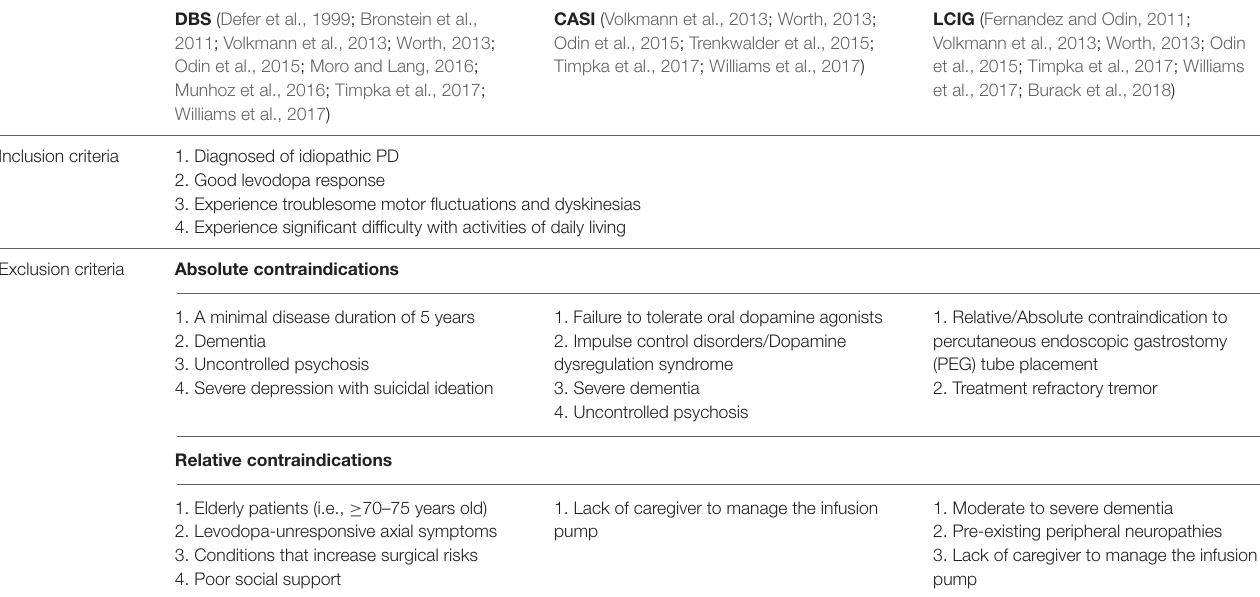
TABLE 1 | Inclusion and exclusion criteria for device-aided therapies of advanced PD. DBS (Defer et al., 1999; Bronstein et al., 2011; Volkmann et al., 2013; Worth, 2013; Odin et al., 2015; Moro and Lang, 2016; Munhoz et al., 2016; Timpka et al., 2017; Williams et al.,